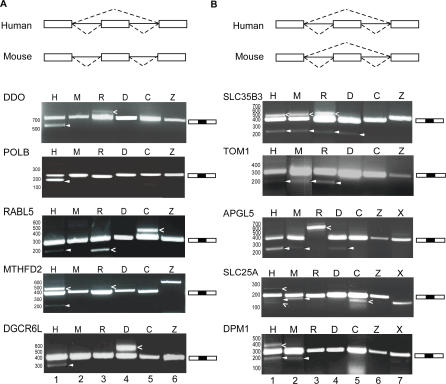
Changes in the Splicing Pattern of Orthologous Exons during Evolution(A) Schematic illustration of the bioinformatics analysis in which the orthologous exon is alternative in human and constitutive in mouse (upper panel). The splicing pattern of five of those exons was tested in several organisms. RT-PCR analysis is shown for normal brain cDNA of human, mouse, rat, and dog (marked H, M, R, and D, respectively), chicken (5-day-old embryos, marked as C), and adult zebrafish whole body (Z). PCR products were amplified using species-specific primers and splicing products were separated on a 2% agarose gel and sequenced. (B) Similar analysis as in panel A, except that the orthologous exons are alternatively spliced with a high inclusion level in both human and mouse. cDNA from Xenopus oocytes (marked X) were also analyzed for some of the orthologs. For APGL5 (lane R), DPM1 (lane H upper band), SLC25A (lane H upper and lower bands and lane C lower band), see Text S5. Gene names are shown on the left (see also Table S2). Arrowheads point to exon-skipping isoform; exon-inclusion isoforms are shown on the right by black and white boxes; open arrows point to non-conserved alternatively spliced products (see Text S5).